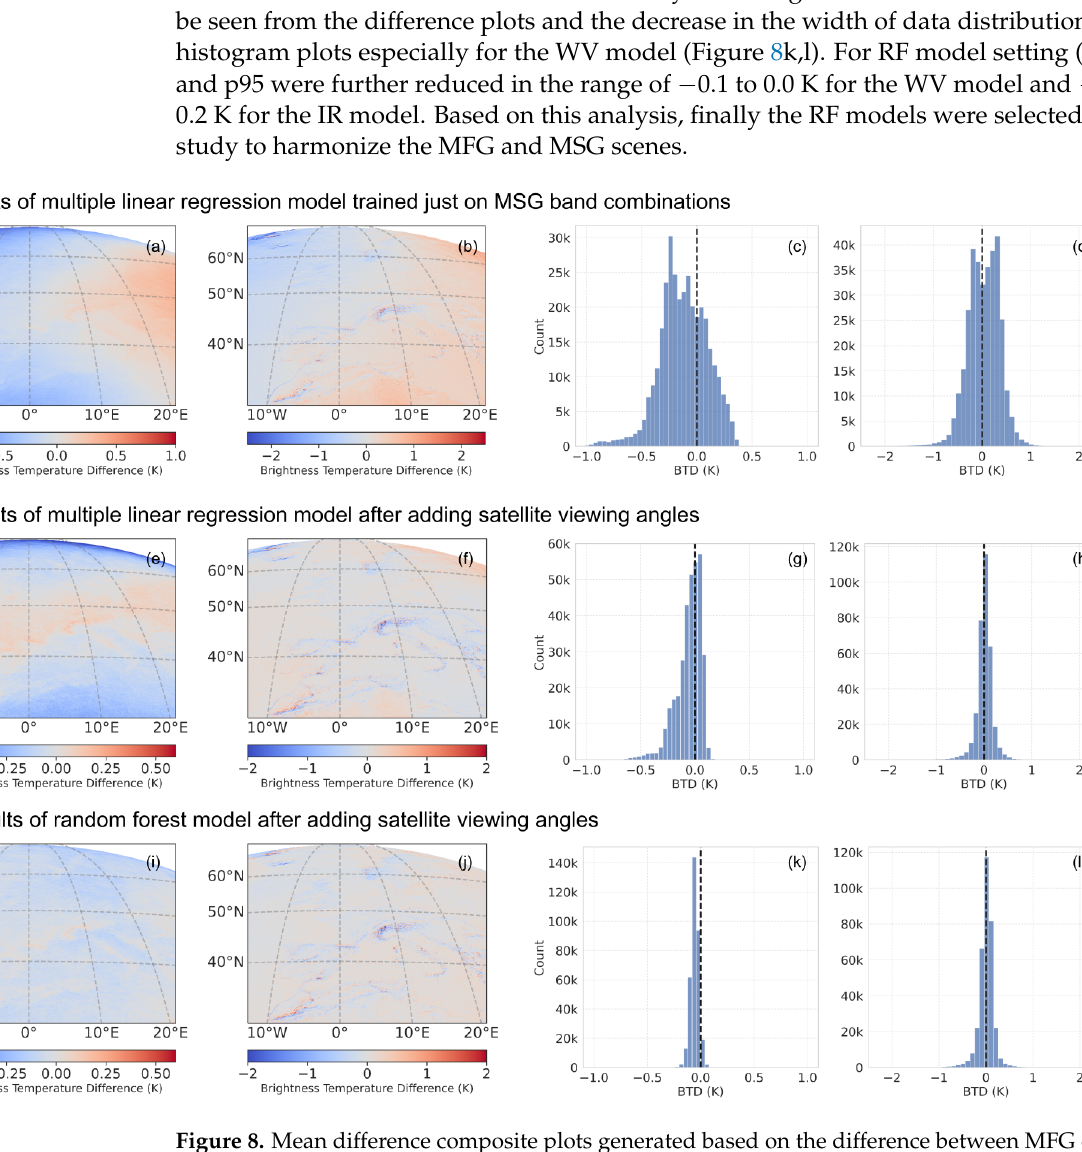
Figure 8. Mean difference composite plots generated based on the difference between MFG original and synthesized WV/IR channels and the histogram analysis of these composites for three different model settings. ( a , e , i ) show the mean difference composites for the WV channel and their histogram plots are shown in ( c , g , k ), respectively. ( b , f , j ) show the mean difference composites for the IR channel with their histogram plots represented by ( d , h , l ) respectively. The values represent the brightness temperature differences (K) between the original and synthesized scenes. These composites are generated by randomly selecting 2000 scenes from the overlap period